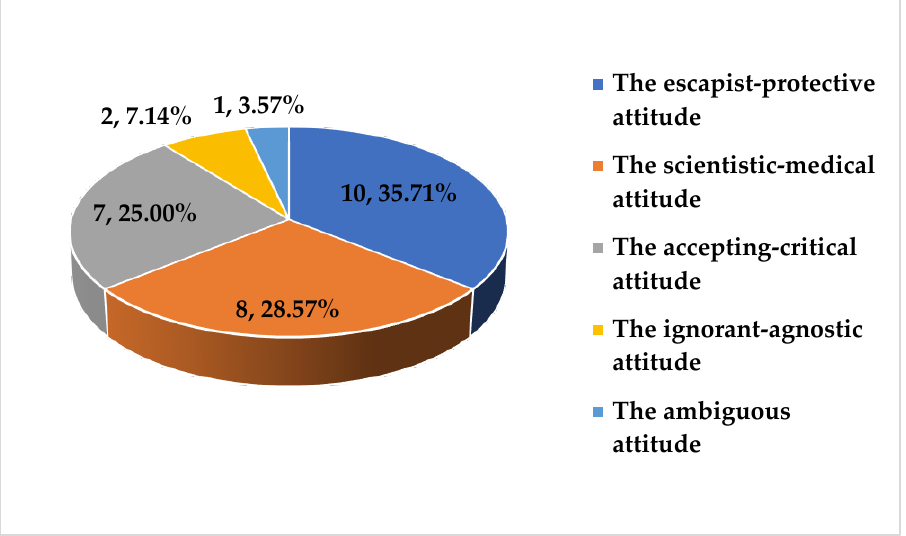
Figure 1. Attitudes of the interviewees towards brain death.